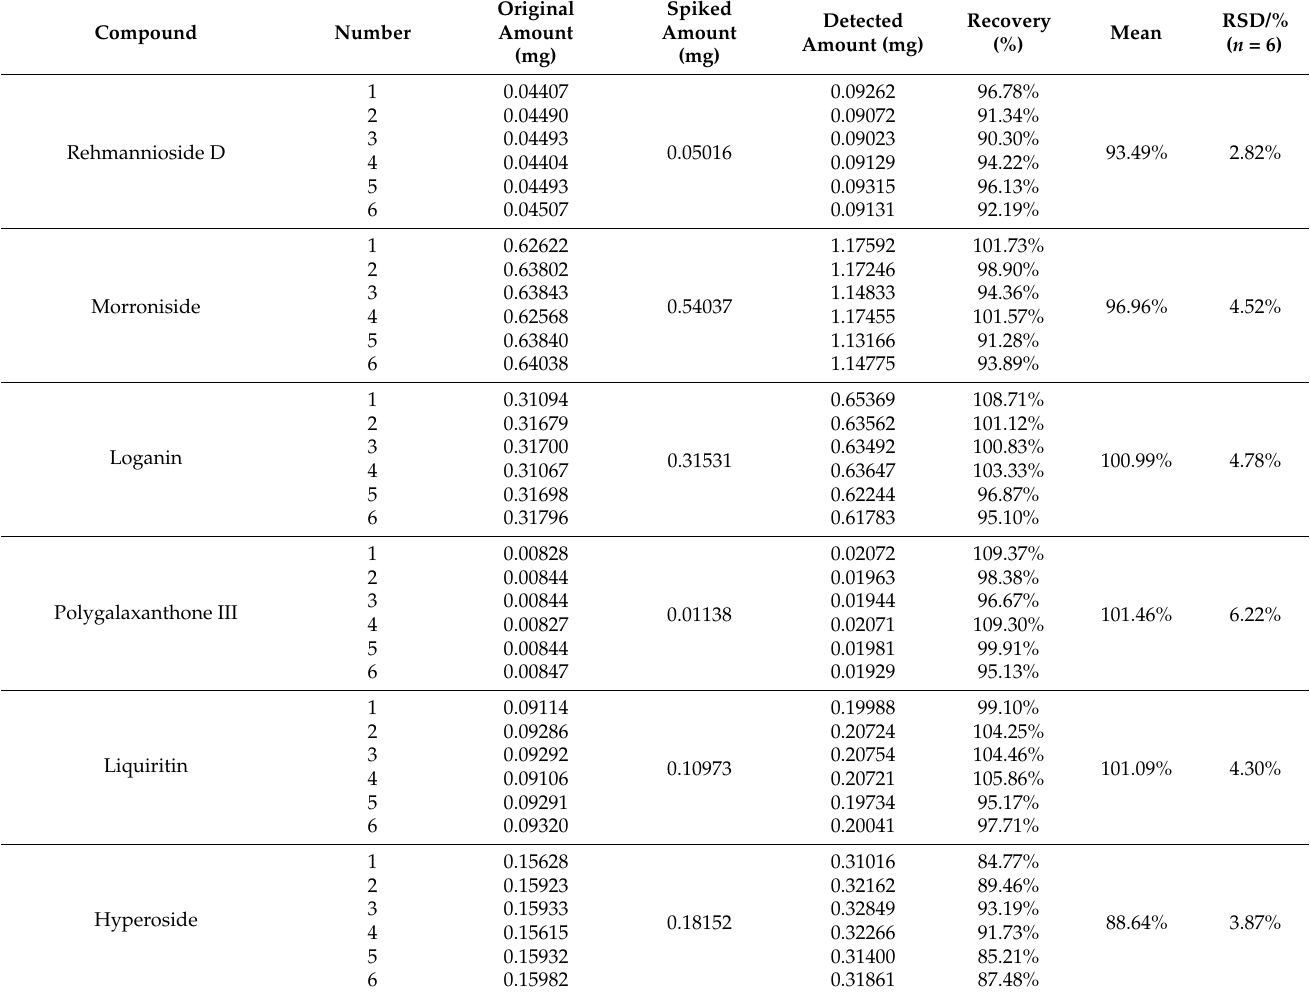
Table 7. Recovery results of 14